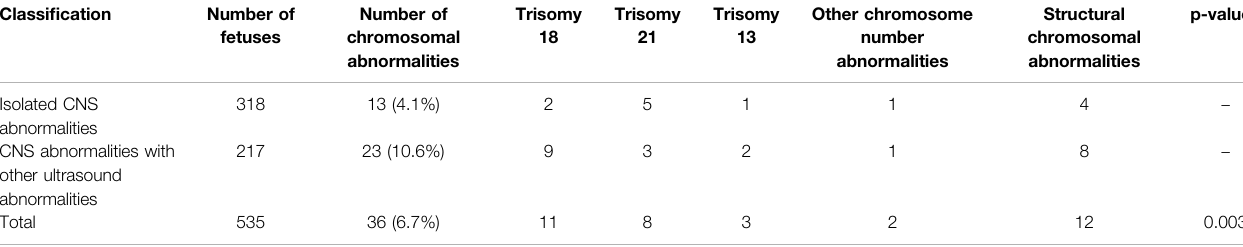
TABLE 2 | The rates of chromosomal abnormalities in isolated CNS abnormalities and CNS abnormalities with other ultrasound